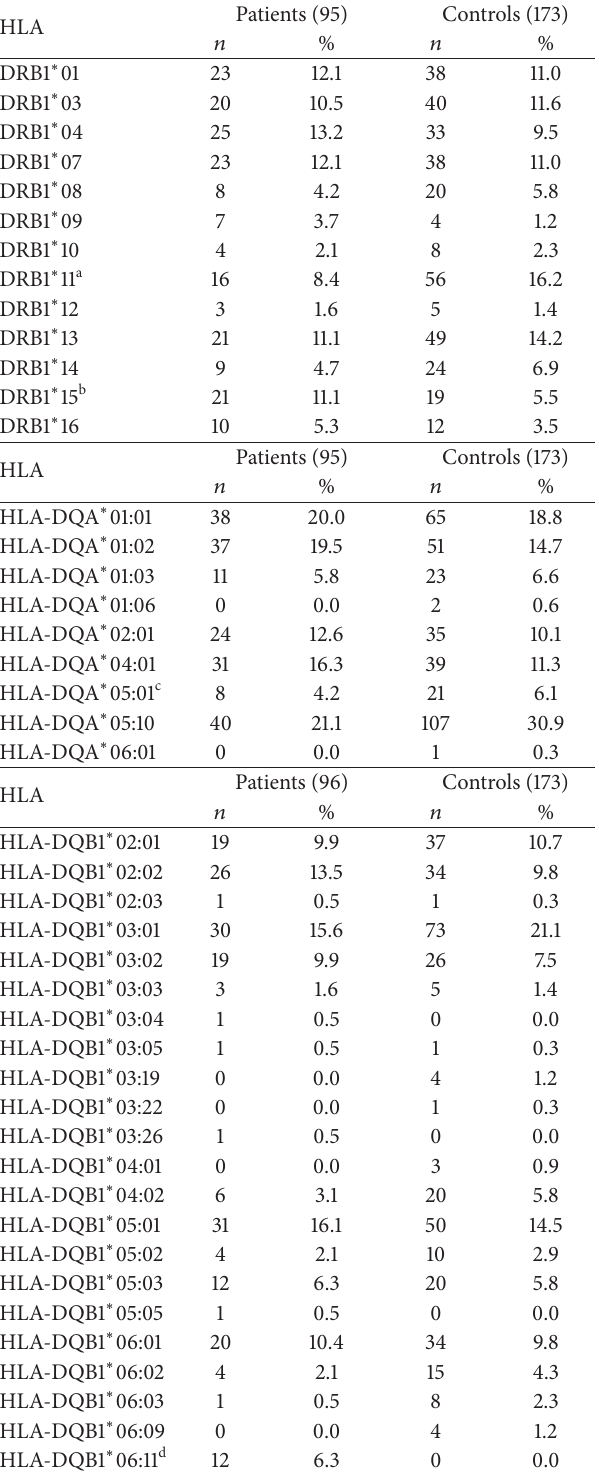
Table 2: Comparison of the frequencies of class II HLA alleles between the control group and patients with clinical-serologic diag- noses of dengue infection in the South of Brazil, occurring in 2007 during a serotype 3 virus